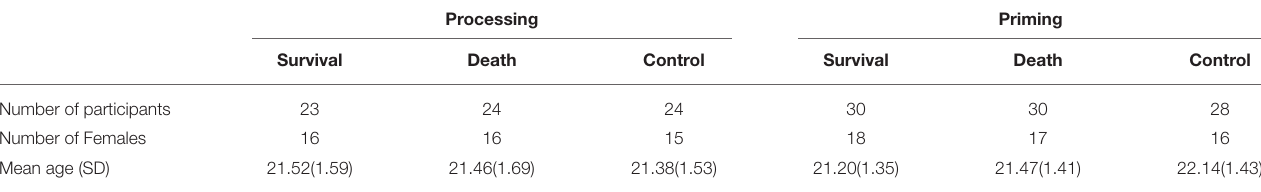
TABLE 1 | Demographic information in each group in experiment 1.